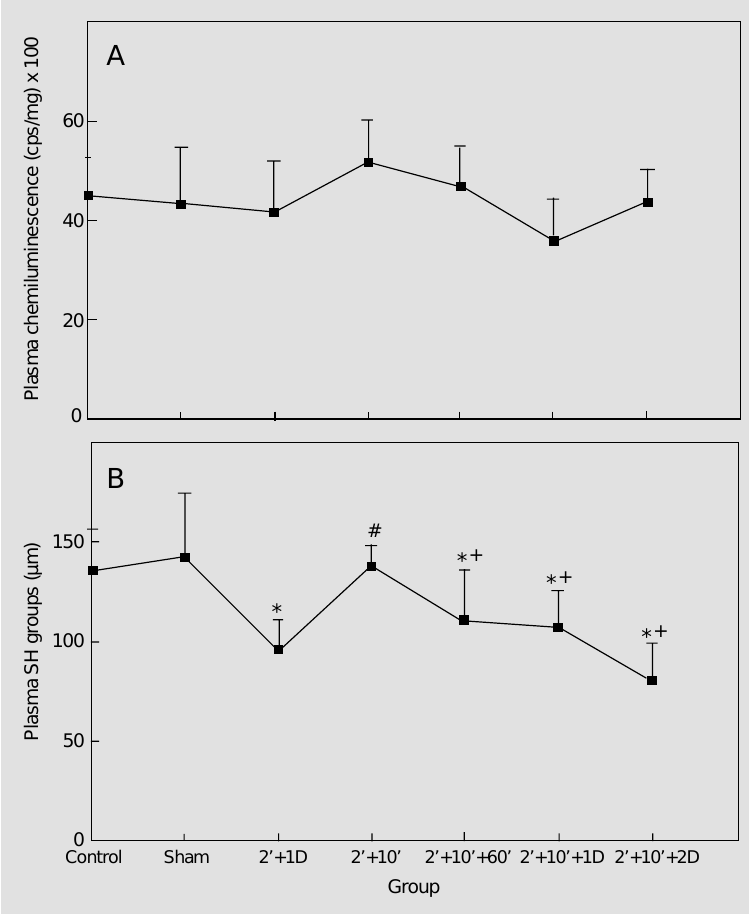
Figure 3 - Effect of brain ischemic preconditioning and reperfusion in rats on tert -butyl hydroperoxide-initiated chemiluminescence of plasma (A) and plasma thiols (B). Rats were submitted to 2-min (2') ischemia followed by 1-day (D) reperfusion (2' + 1D) and 10-min (10') ischemia 1 day after a 2-min ischemic episode (2' + 10'). Rats were also submitted to 60 min or 1 and 2 days of reperfusion after the double-ischemic episode (2' + 10'). Data represent the mean ± SD for six to nine different animals. *P<0.05 compared to the control group. # P<0.05 compared to the (2' + 1D) group. + P<0.05 compared to the (2' + 10') group (Duncan multiple range test). SH,